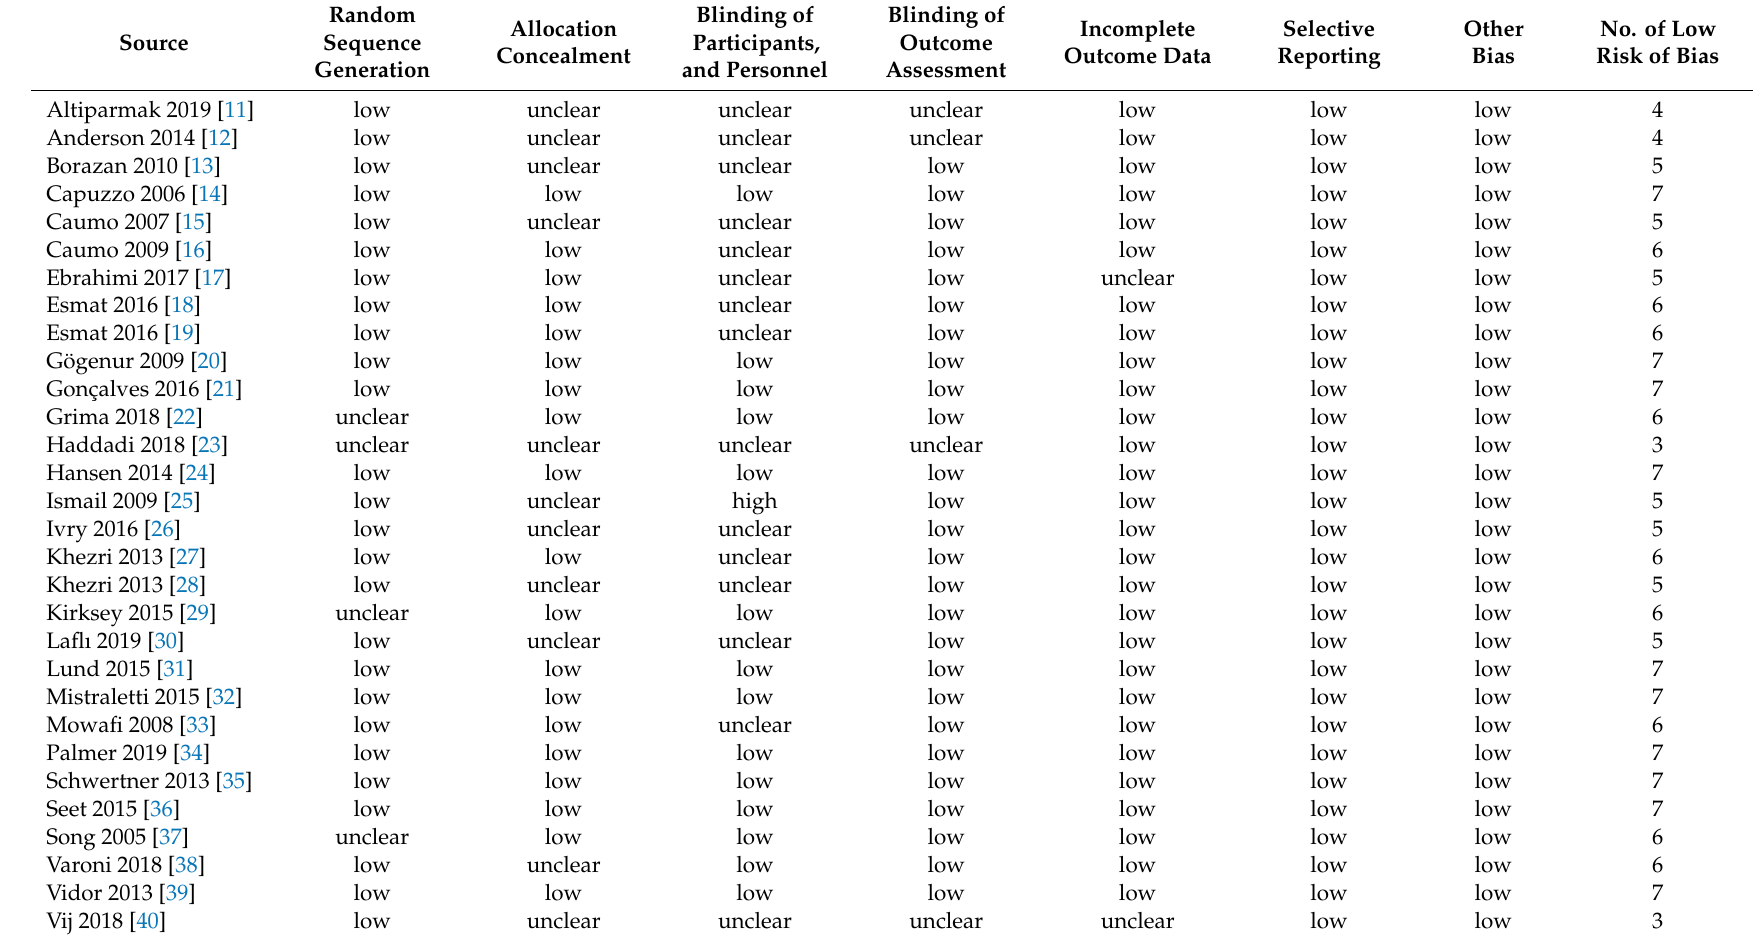
Table 2. Summary of risk of bias assessment for randomized, double-blind, placebo-controlled trials.